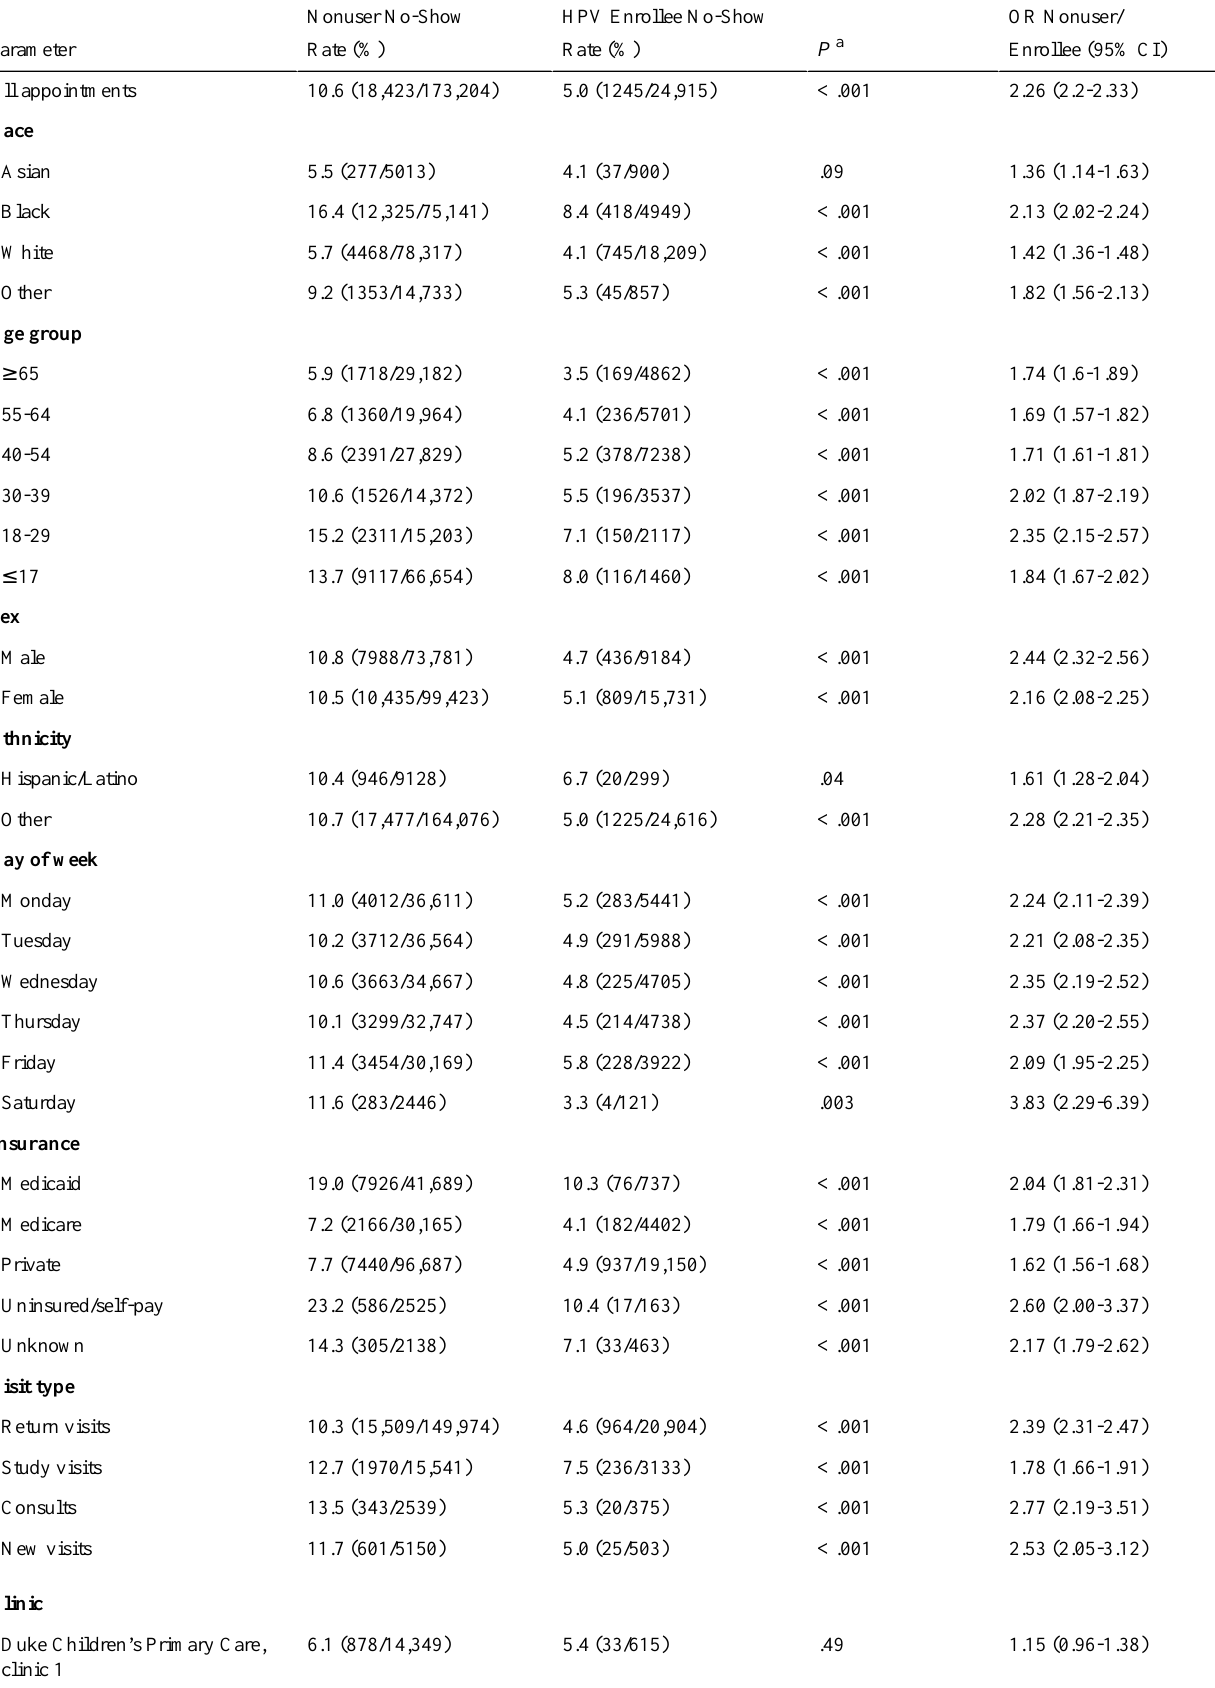
Table 2. No-show rates by portal enrollee status at time of clinic appointment